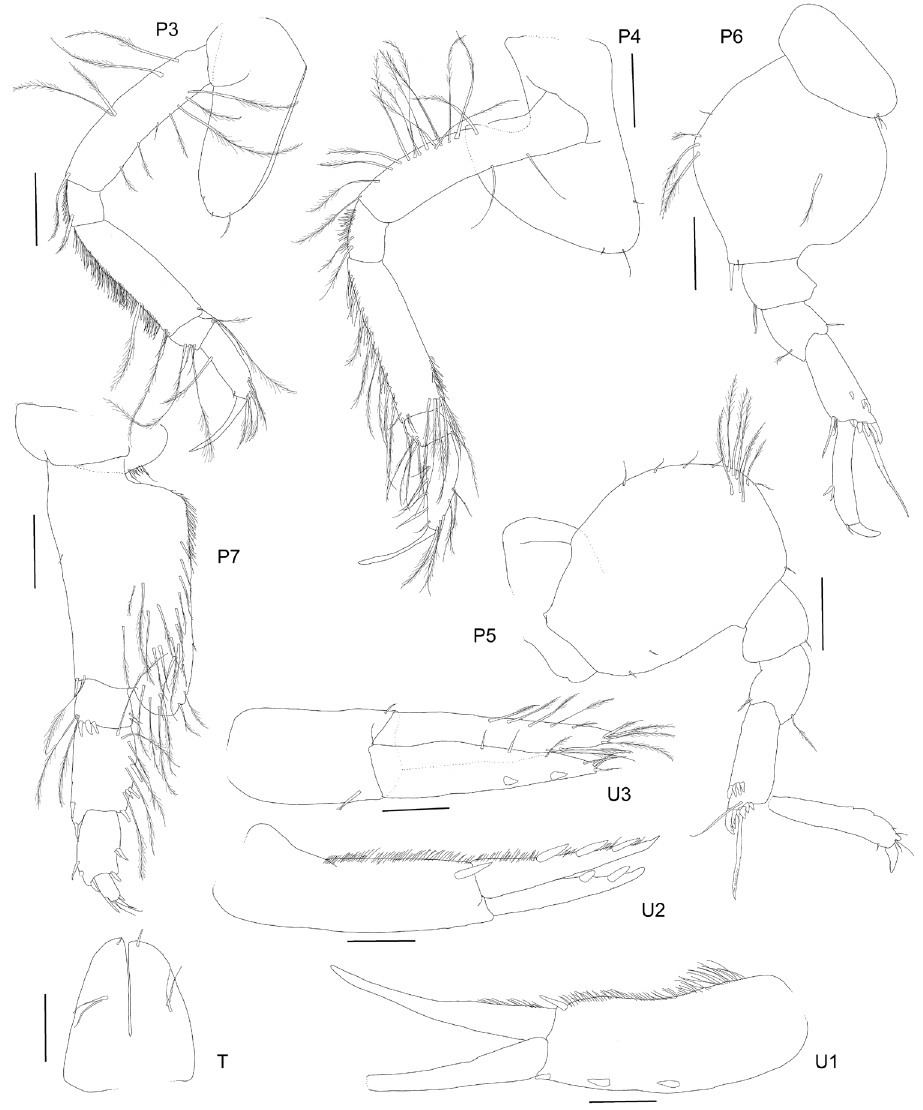
Figure 8. Haploops kaimmalkai sp. n. holotype, female, 6 mm, ZMH K-47057, Iceland Basin, 1384.8– 1389 m. Whole animal, head and epimeron. Habitus scale represents 1